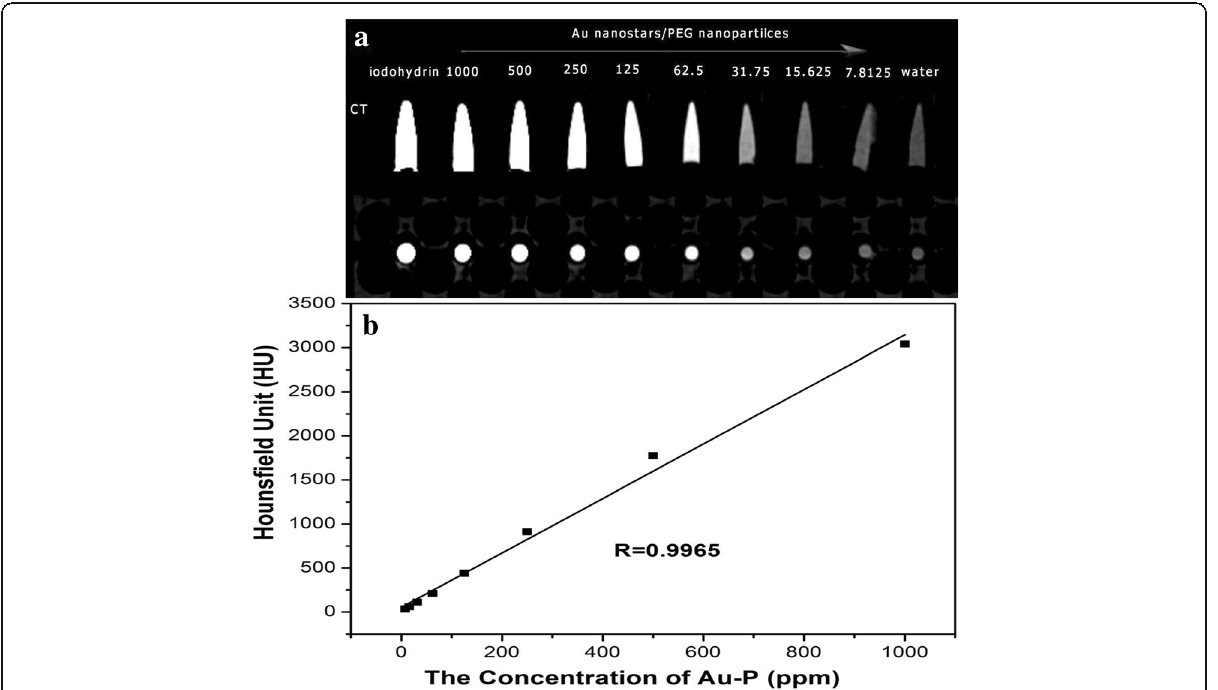
Fig. 2 The X-ray attenuation intensity of the AuNS@PEG nanoparticles as a function of the Au concentration ( a ) and CT image of the AuNS@PEG nanoparticles under different concentrations (iodohydrin, 1000, 500, 250, 125, 62.5, 31.75, 15.625, and 7.8125 ppm, respectively) ( b